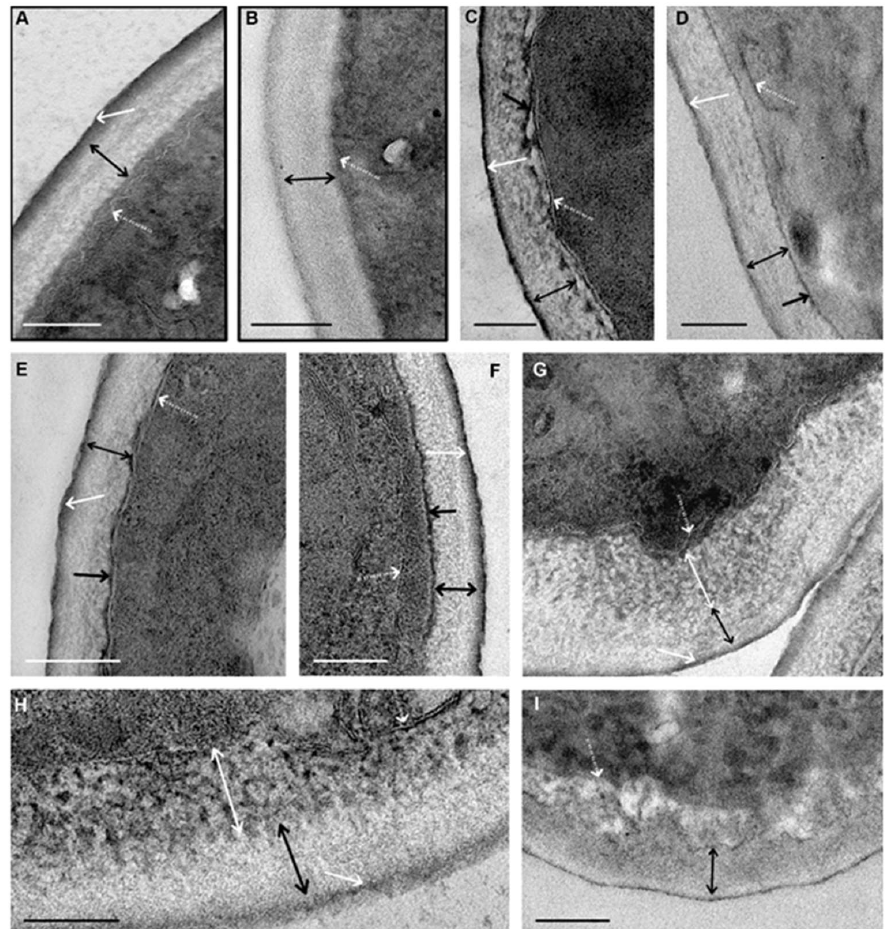
Figure 4. Changes in the ultrastructure of cell walls of C. albicans at the greatest severity when exposed to the peptides (KFF)3K ( C – F , 2 h incubation) and R9F2 ( G – I , 6 h incubation). For comparison: ( A , B ) cell wall of the yeast intact cells (framed). White dotted arrows show the plasma membrane; white arrows–wall outer electron-dense layer; black two-way arrows–wall inner layer; black arrows show the layer of electron-dense substances on the wall inner surface; white two-way arrows show fibrillar structures. ( B , D ) sections without contrasting. Scale bars correspond to 200 nm.